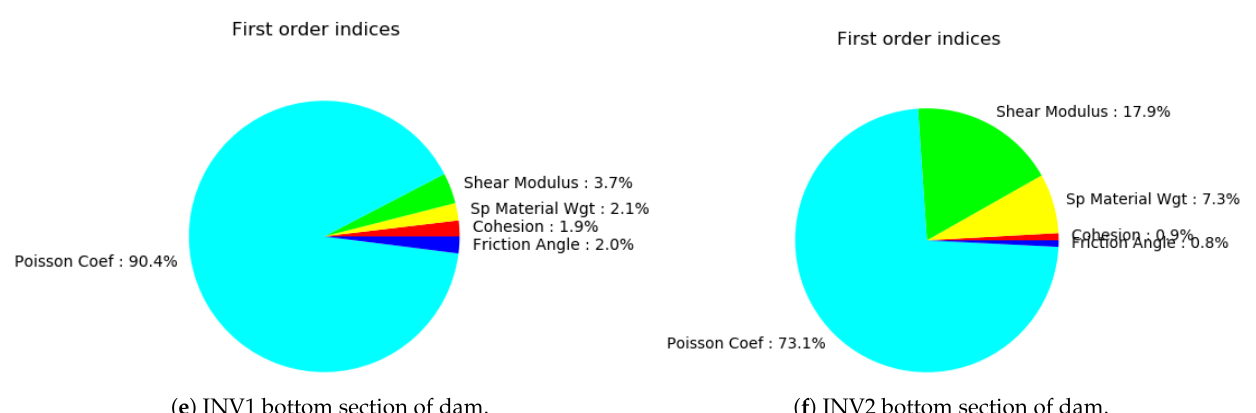
Figure 10. The pie charts show the sensitivity indices based on PCE for INV1 and INV2 vertical displacements,